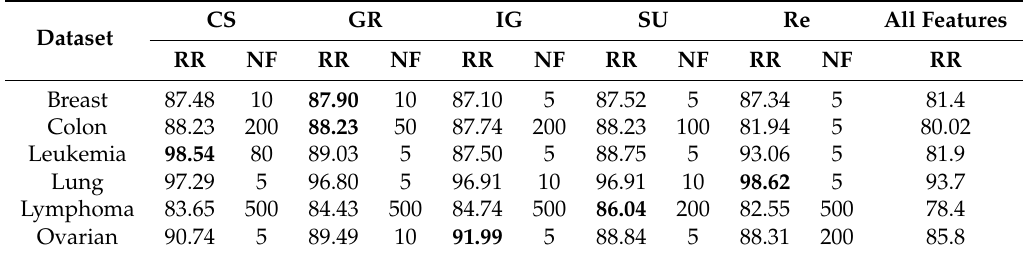
Table 2. Best results of ranking-based feature-selection methods with DT